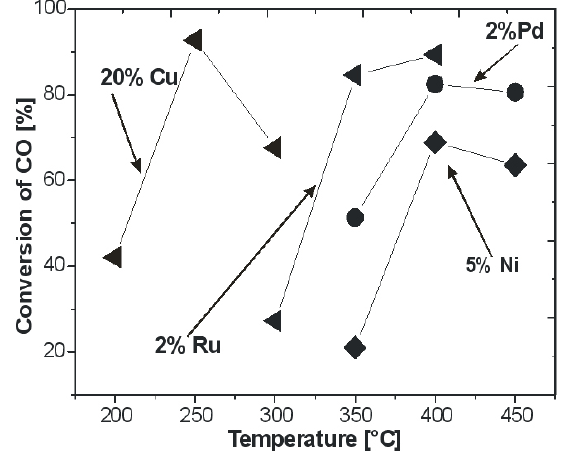
Figure 5. Activity tests in WGS reaction of various metal catalysts after reduction at 350°C in pure hydrogen (Pd, Ru, Ni) or at 300°C in 5% H -95% Ar mixture in the case of 2